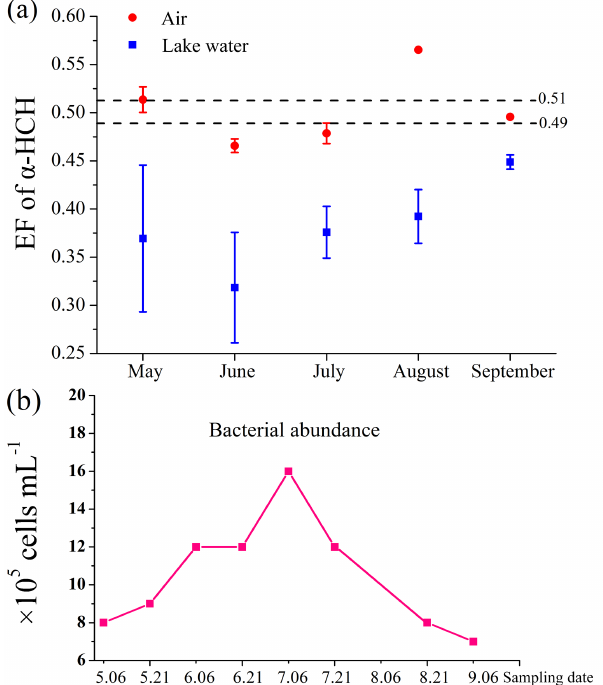
Figure 5. Enantiomer fraction (EF) of α -HCH in the air and sur- face water from May to September (a) , and the seasonal bacterial abundance in Nam Co lake water (b) . The data of bacterial abun- dance was derived from Liu et al. (2013), which represents the total bacteria in the lake surface